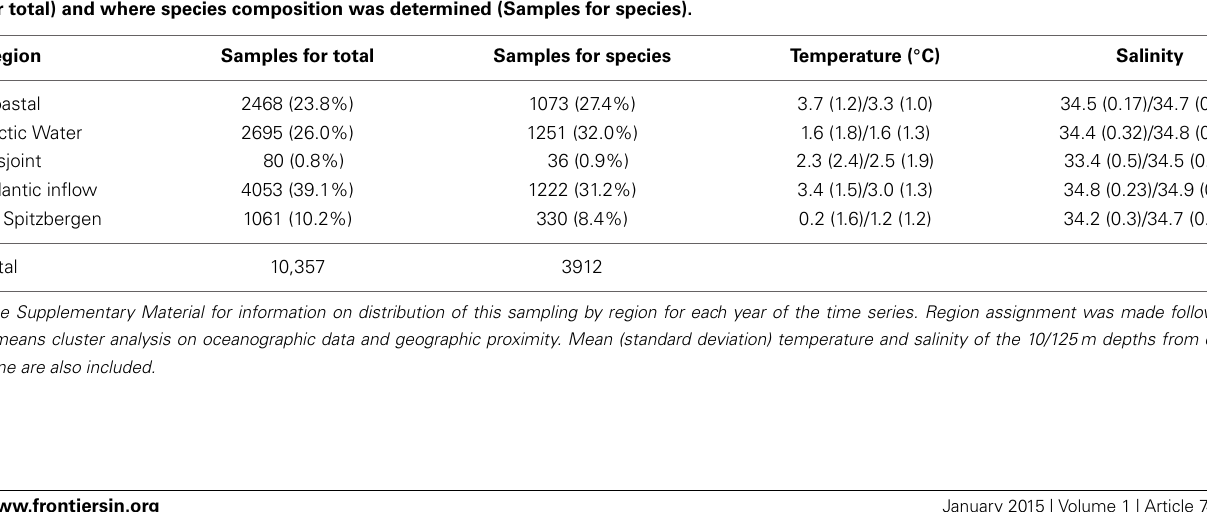
FIGURE 2 | Location of 10,357 euphausiid sampling stations in the Barents Sea related to oceanographic parameters—gray- bluish, Coastal waters; green, Arctic waters; red, disjoint